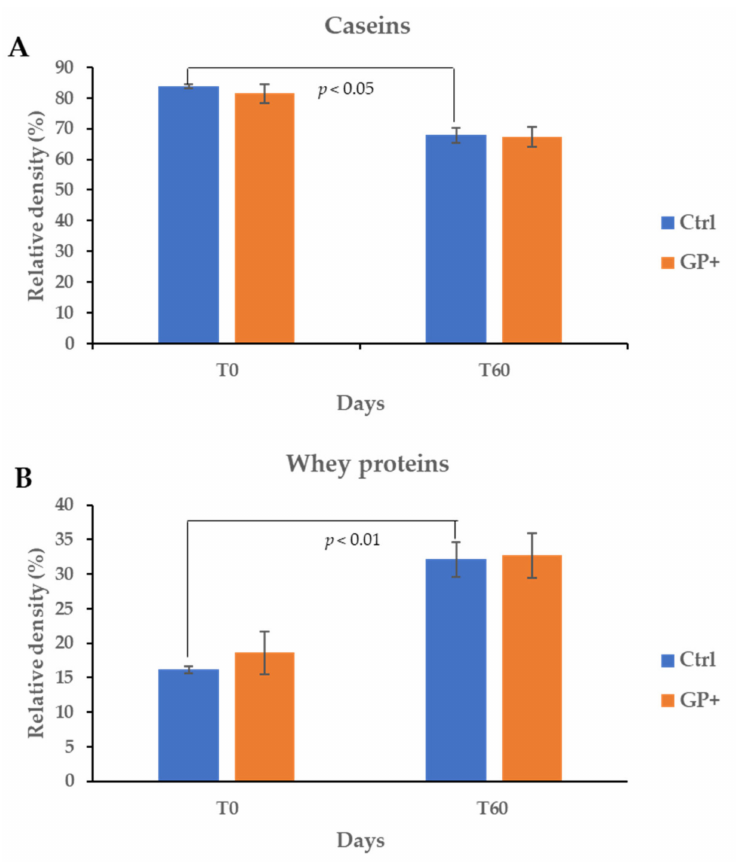
Figure 2. Total caseins ( A ) and whey proteins ( B ) at the beginning (T0) and after 60 (T60) days of trial in raw milk samples obtained from ewes fed a standard diet (Ctrl) and grape pomace diet (GP+). Data are reported as mean percentage ± SE for n = 23. Differences between Ctrl and GP+ were not significant ( p >